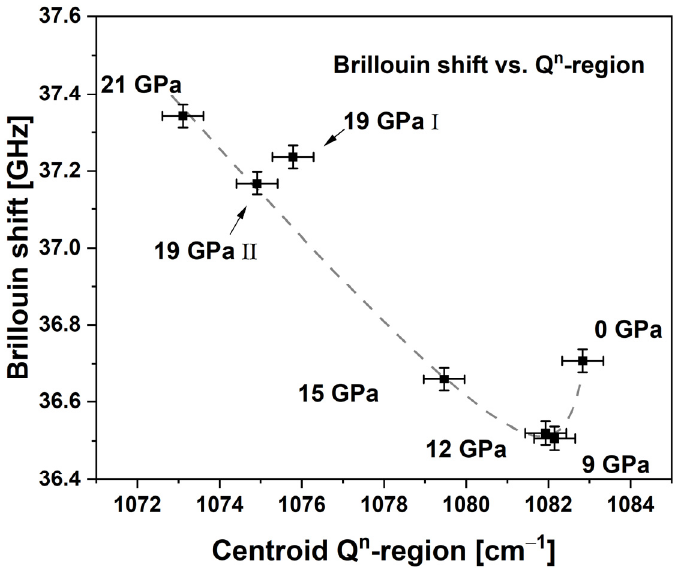
Figure 14. Comparison of the Brillouin shift with the centroid of the Raman Q n -region (gray dashed line is only a guide to the eye); using this cross spectral observation the samples densified >9 GPa are almost aligned and the non-hydrostatical sample at 19 GPa I in seen to be clearly out of trend.